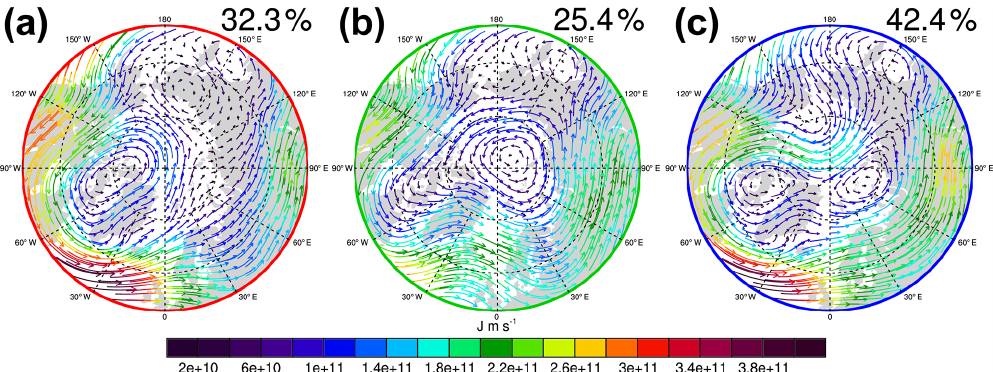
Figure 2. The three different transport pathways: the North Atlantic pathway ( a ; red coloured frame), the Siberian pathway ( b ; green coloured frame), and the North Pacific pathway ( c ; blue coloured frame), derived from the composites of the selected patterns of Fig. 1 weighted by their relative frequency of occurrence within the